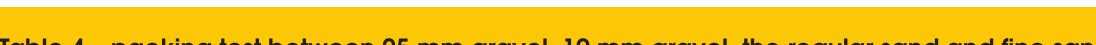
Table 4 – packing test between 25 mm gravel, 19 mm gravel, the regular sand and fine sand